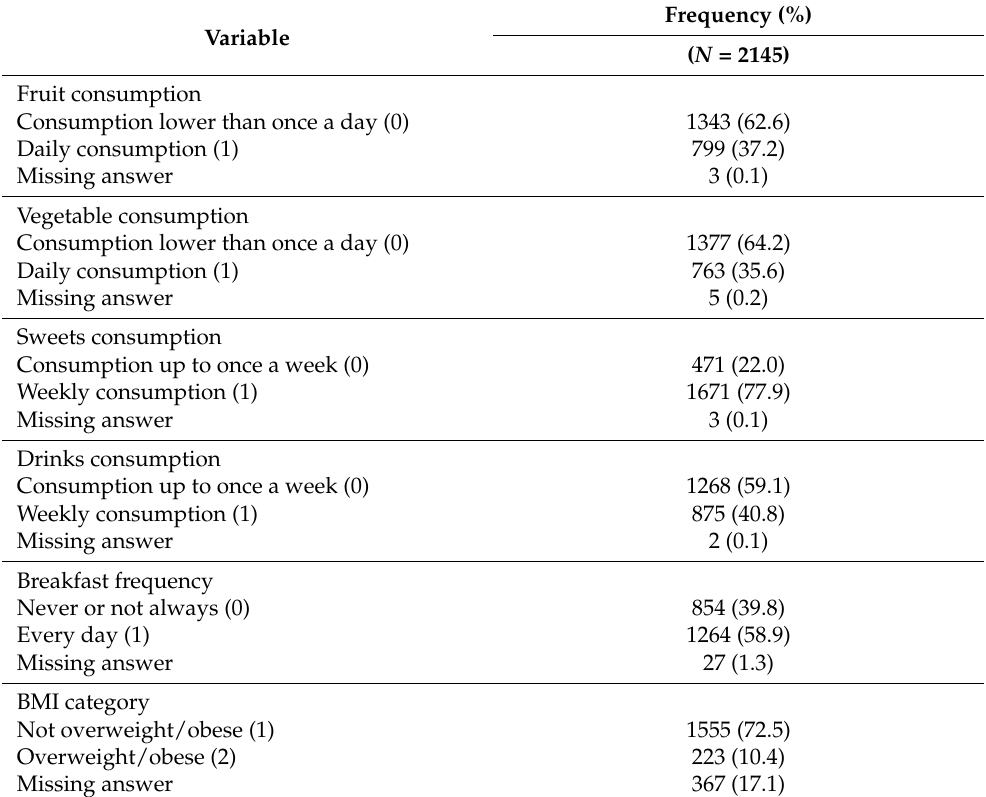
Table 2. Frequencies of outcome